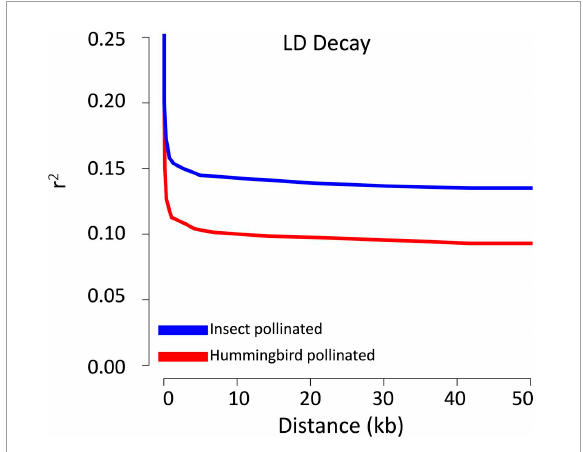
FIGURE7 Decay of linkage disequilibrium ( r 2 ) using filtered genome wide SNPs for accessions representing either bee or bird